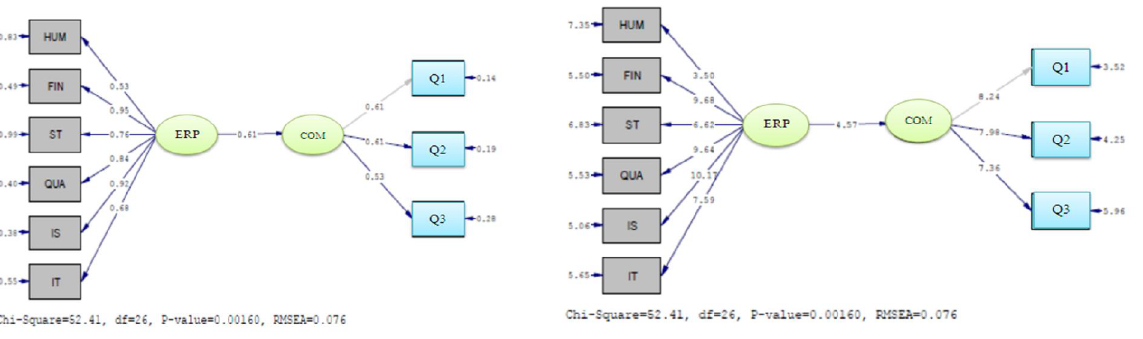
Fig. 2. The results of the implementation of structural equation modeling for the main hypothesis